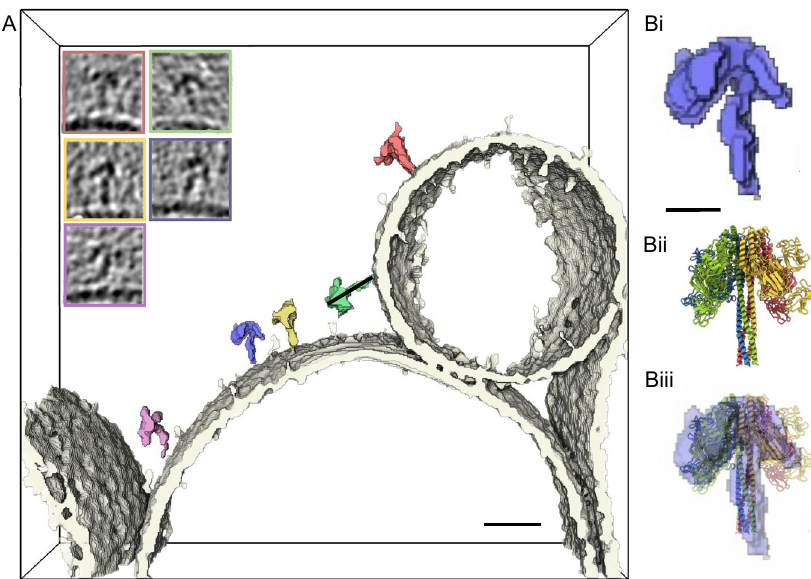
Fig. 3 Vip3 act directly visualised on liposome membranes. Segmented density from cryo-ET shows interaction of Vip3Bc1 act (coloured) with the LUV membrane (white). Images inset show section through the tomogram of the matching particle in segmentation. Full tomogram can be visualised in Supplementary Movie 1. Scale bar 20 nm. B Scaled comparison between segmented density for a single particle in the tomogram, with 5 nm scale bar (i) compared to Vip3Bc1 act model (ii) with an overlay showing the stalk density fi ts the 4-helix bundle well, and the density which is distal to the membrane is consistent with single particle Vip3Bc1 act model. The helical stalk modelled in Vip3Bc1 act does not account for all of the stalk density observed in the sub-